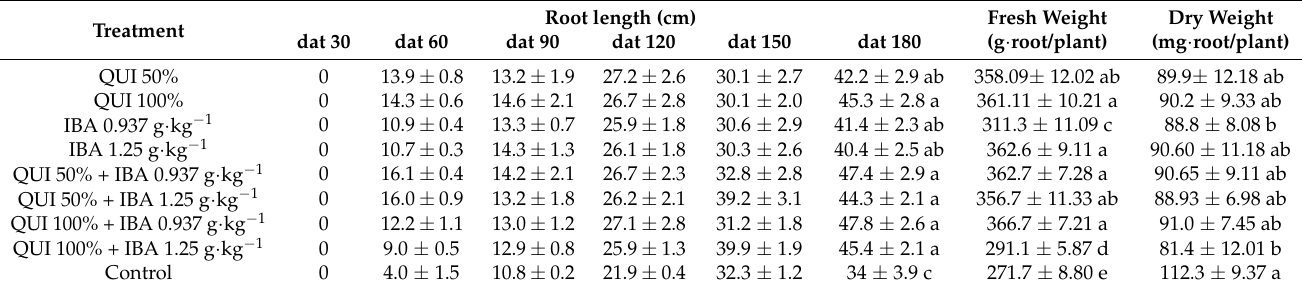
Table 4. Mean values of root length (dat), fresh and dry root weight in cuttings of S. bigelovii treated with Chitosan (QUI) and Indole butyric acid (IBA) from two phenological cycles under conditions in the Altar desert, Sonora.